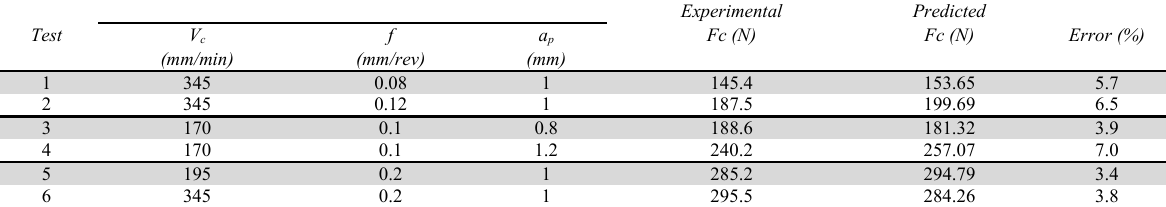
Conformation test values of cutting force